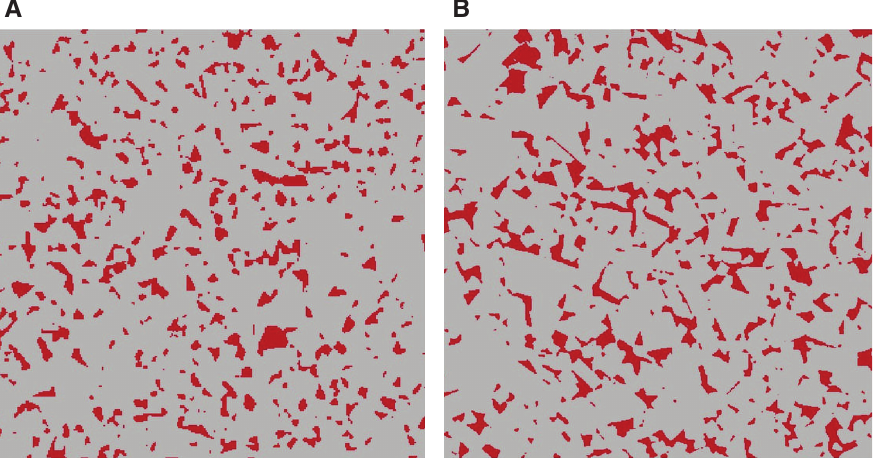
Figure 2: Two-dimensional microgeometries created based directly on micrographs of cemented carbide containing (A) 6% of cobalt and (B) 9% of cobalt.